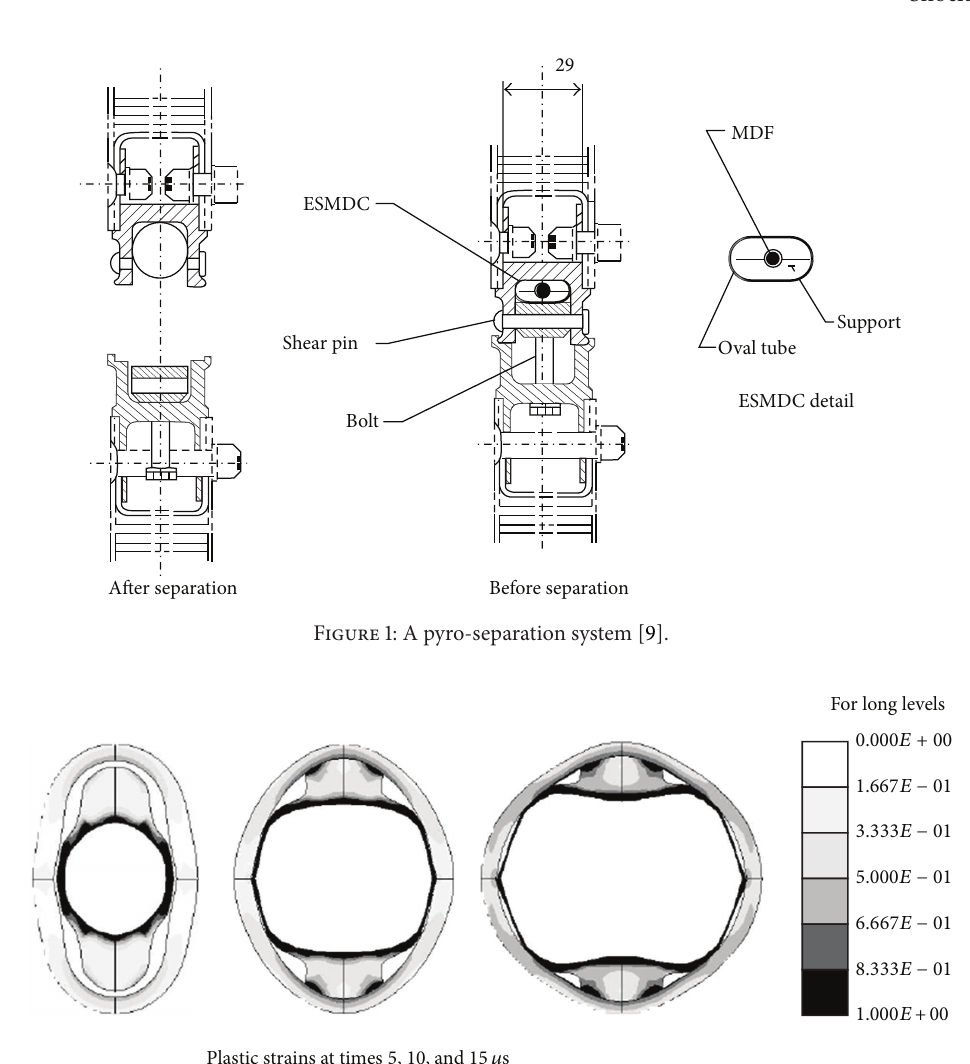
Figure 2: Numerical simulation of expanding tube free expansion [10].